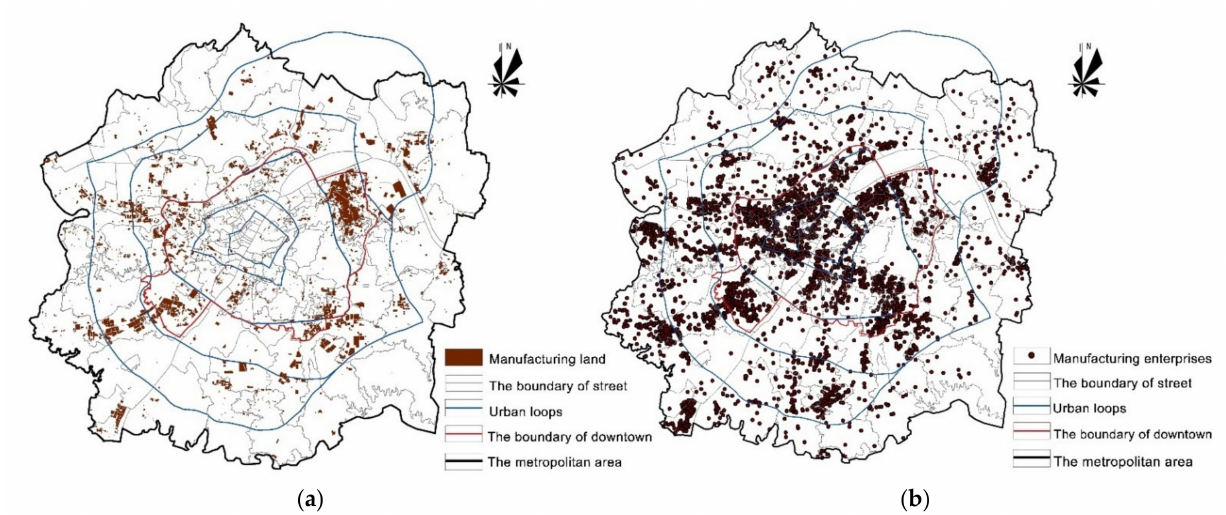
Figure 2. Object of the study: ( a ) distribution of manufacturing land in the Wuhan metropolitan area; ( b ) distribution of manufacturing enterprises in the Wuhan metropolitan